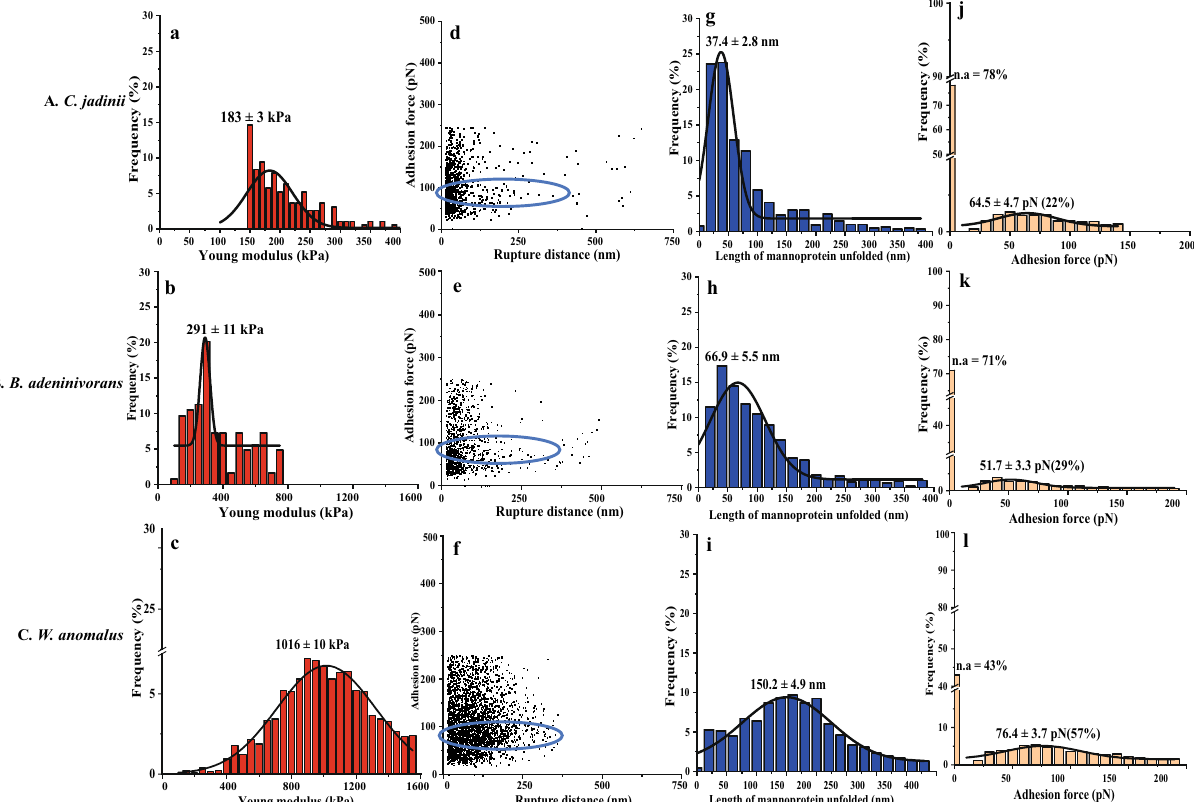
Figure 6. Probing cell wall architecture of three autolyzed yeast species ( A – C ) with Atomic Force Microscopy, using naked tips ( a – c ) or tips functionalized with (mannan-binding) concanavalin A ( d – l ). The graphs show the distribution of the Young modulus ( a – c ), the relationship between adhesion force and rupture distance ( d – f ), the distribution of the length of mannoprotein unfolded ( g – i ), and the frequency of adhesion events with varying adhesion forces ( j – l ). In panels j–l, n.a . stands for non-adhesion. Rows A , B and C show results for Cyberlindnera jadinii , Blastobotrys adeninivorans and Wickerhamomyces anomalus , respectively. The data were obtained from 3 cells (3072 curves were analyzed with JPK data processing software before fitting Gaussian curves on the distribution). The blue circle highlights the rupture distance at the adhesion force for